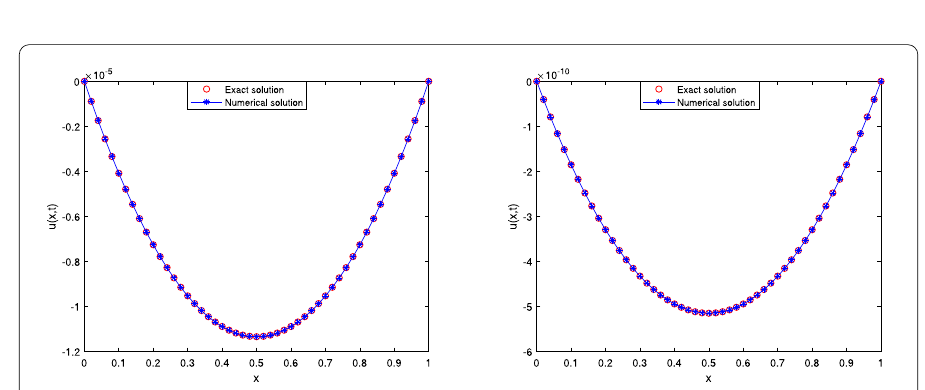
Figure 2 Approximate and exact solutions of Example 6.1 for n = 3 with final times T = 5 (left), T = 10 (right), and φ ( h ) = 4sinh( h